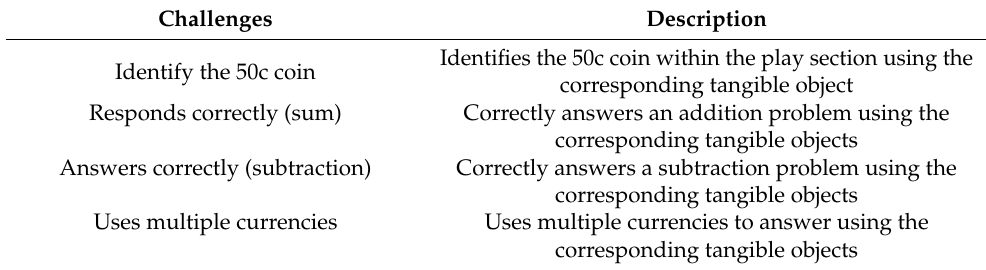
Table 3. Missions implemented in the “Learning with Pesos” game.